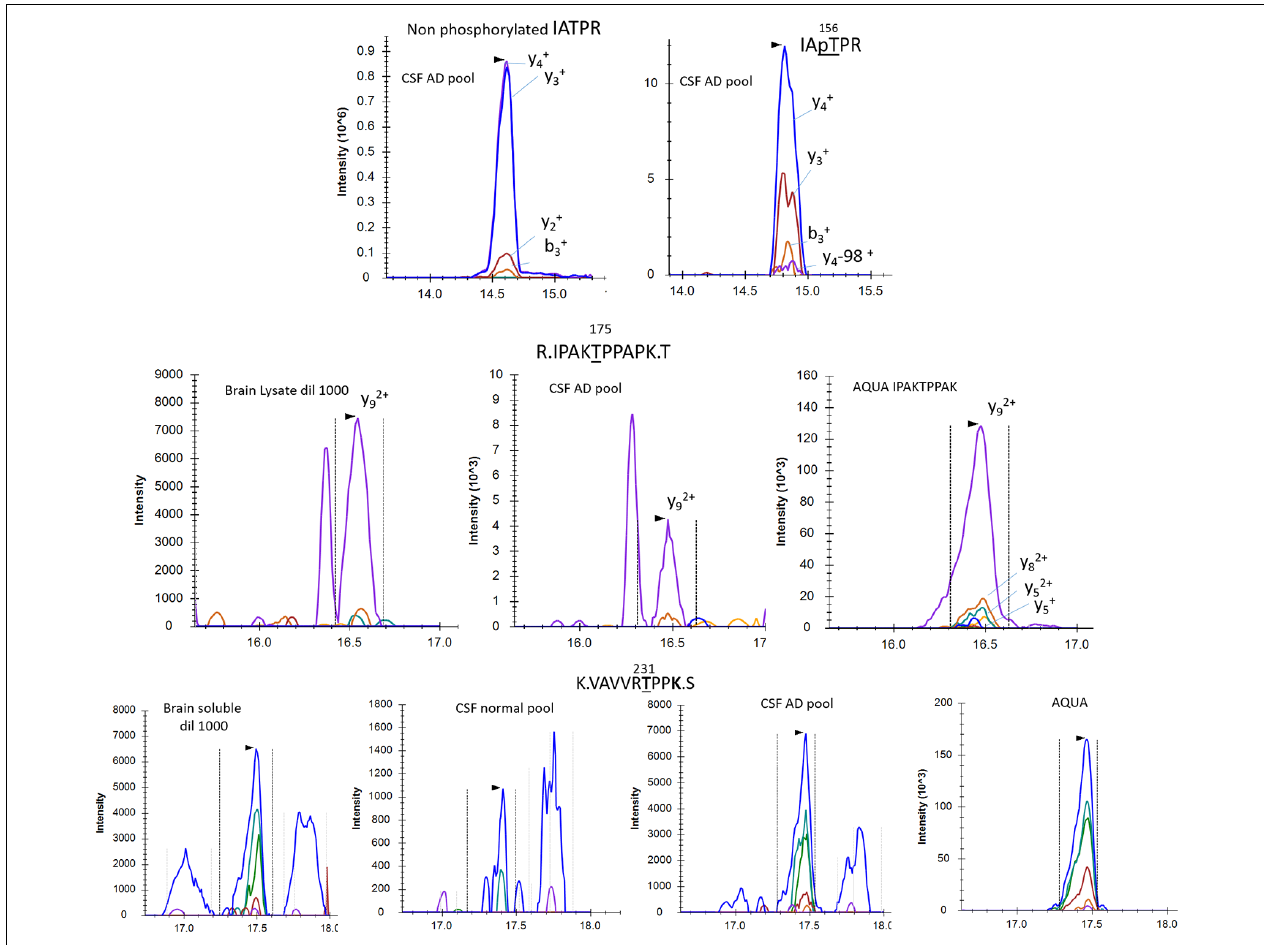
FIGURE 9 | pT153, pT175 and pT231 phosphorylated peptides identified in CSF. AQUA internal standard signals are shown for pT175 and pT231. Fragmentation pattern of pT153 is similar to unmodified.